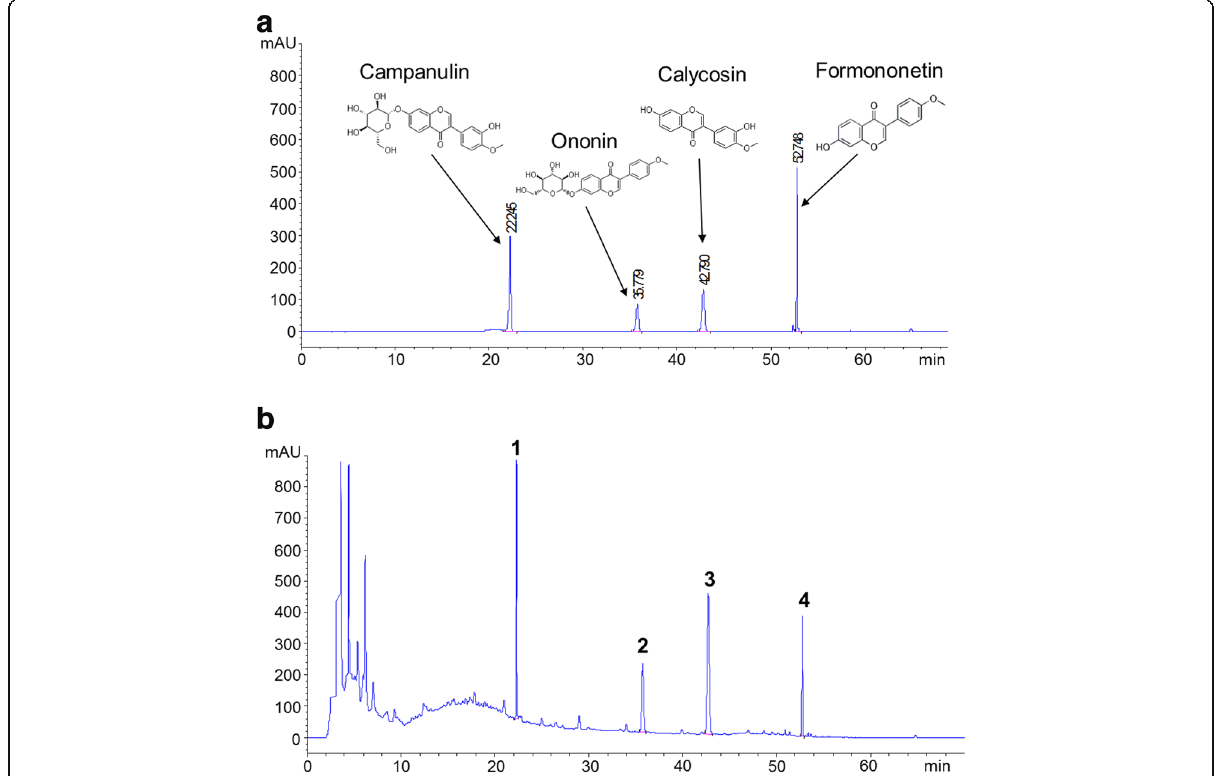
Fig. 2 HPLC profile of AM extract. a HPLC chromatogram of mixed standard solutions, campanulin, ononin, calycosin, and formononetin. b HPLC chromatogram of AM extract. Campanulin, ononin, calycosin, and formononetin were detected in AM extract. The retention times were 22.245 min (peak 1), 36.779 min (peak 2), 42.79 min (peak 3), and 52.748 min (peak 4),